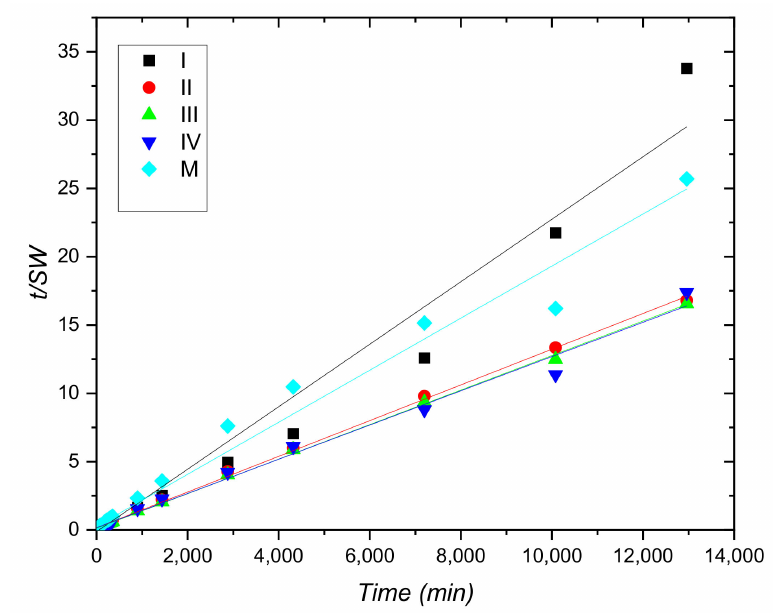
Figure 6. The plot t/SW as a function of t .